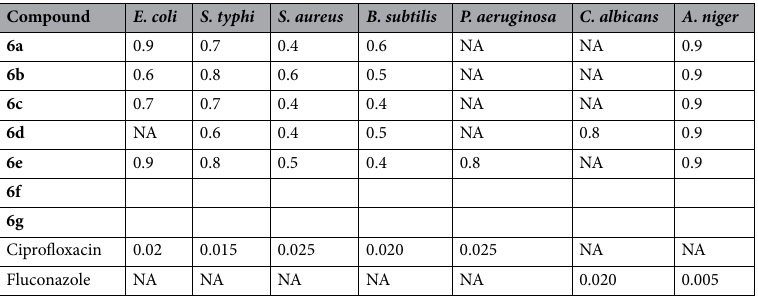
Table 10. Minimum inhibitory concentration (MIC, mg/mL). NA no activity.